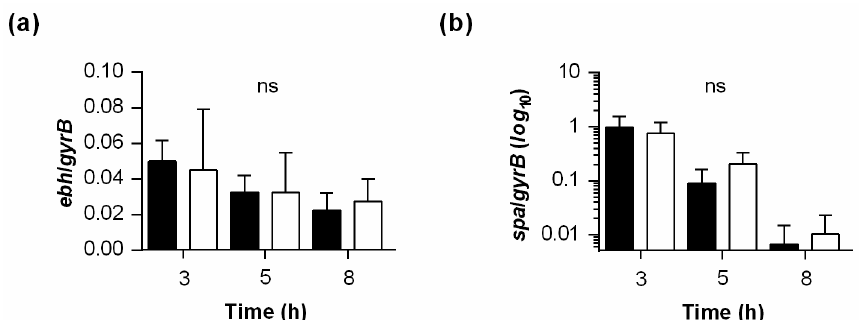
Figure 6. Effect of a ptpB deletion on the transcription of MgrA-repressed surface factors encoding genes. Quantitative transcript analyses of MgrA-regulated genes ebh ( a ) and spa ( b ) by qRT-PCR in SA564 (black bars) and SA564 ∆ ptpB (white bars) cells grown in TSB at 37 ◦ C and 225 rpm to the time points indicated. Transcript rates were quantified in reference to the transcription of gyrase B (in copies per copy of gyrB ). Data are presented as mean + SD of five biological replicates. ns, not significant (Mann–Whitney-U test between wild-type and mutant at a given time point).